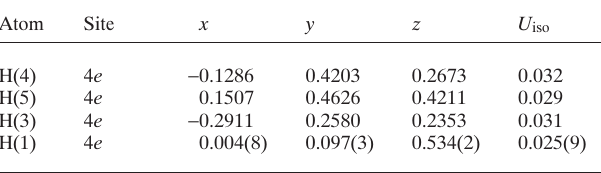
Table 2. Atomic coordinates and displacement parameters (in Å 2 )